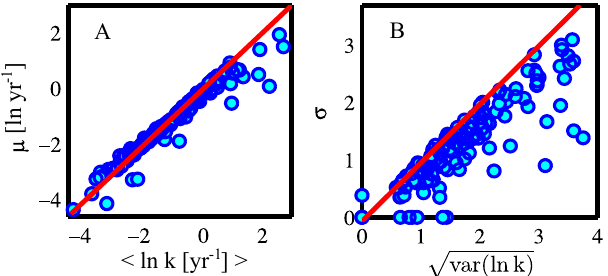
Fig. 6. Comparison of µ and σ estimated from the nonlinear fitting procedure to the mean h ln k i and standard deviation of the regular- ized distribution ρ . (A) the mean h ln k i of ρ( ln k) vs. µ . (B) the standard deviation of ρ( ln k) vs. σ